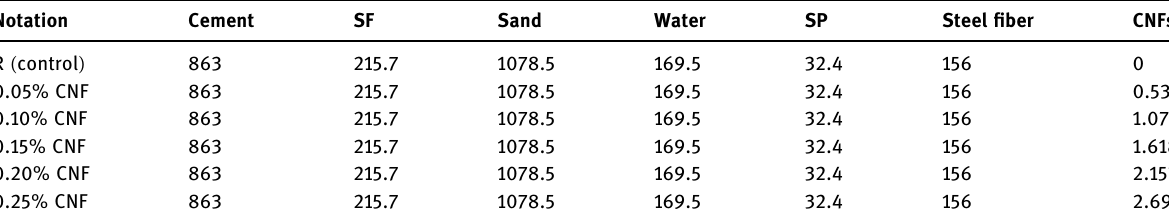
Table 2: Mix design of UHPC mixtures in this study ( kg/m 3 )